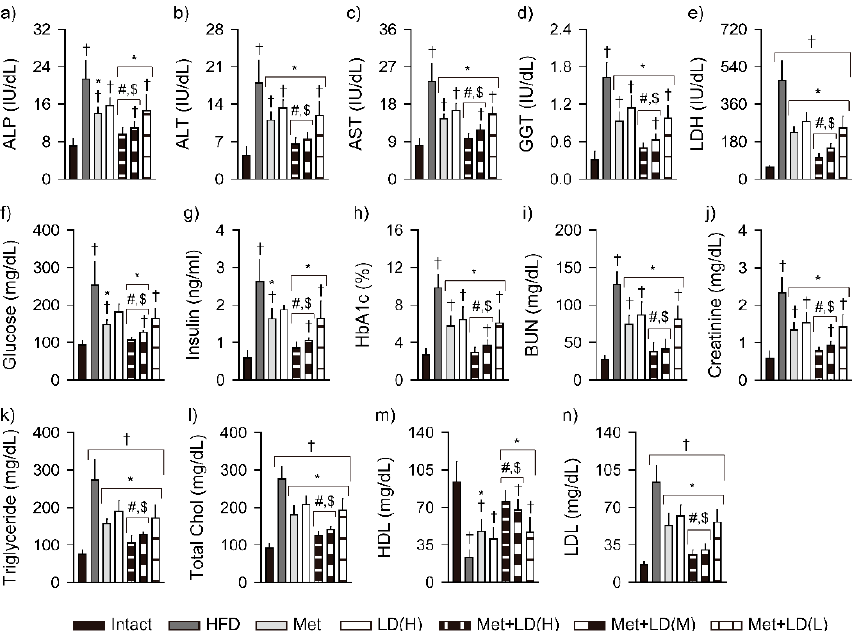
Figure 4. Combination effects on parameters in blood biochemistry. ( a – n ) Blood levels of alkaline phosphatase (ALP), alanine aminotransferase (ALT), aspartate aminotransferase (AST), gamma-glutamyltransferase (GGT), lactate dehydrogenase (LDH), glucose, insulin, blood glycated hemoglobin (HbA1c), blood urea nitrogen (BUN), creatinine, triglyceride, total cholesterol (Chol), and low-/high-density lipoprotein cholesterol (LDL/HDL). Values are represented as the means ± SDs ( n = 8). †, *, #, and $: p < 0.05 vs. the Intact, HFD control (HFD), Met, and LD(H) groups,